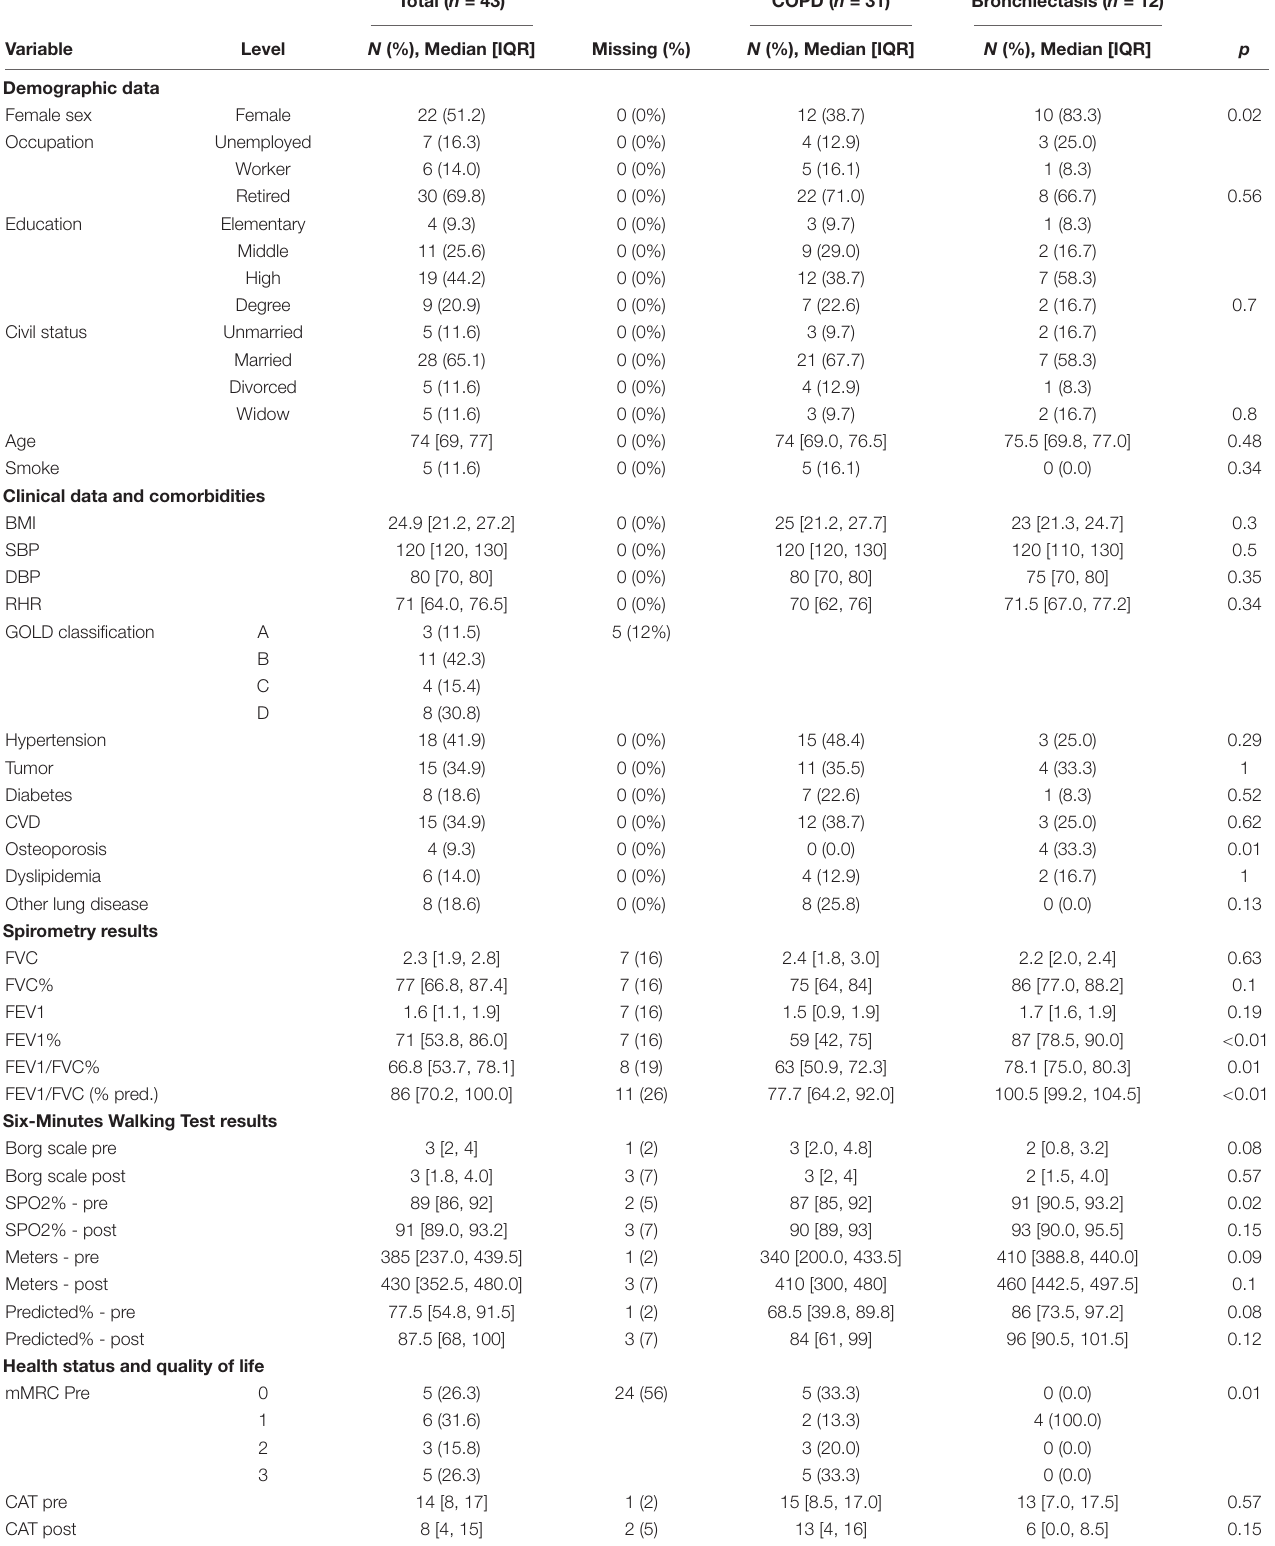
TABLE 1 | Demographic and clinical characteristics of the sample. Total ( n = 43) COPD ( n = 31) Bronchiectasis ( n =